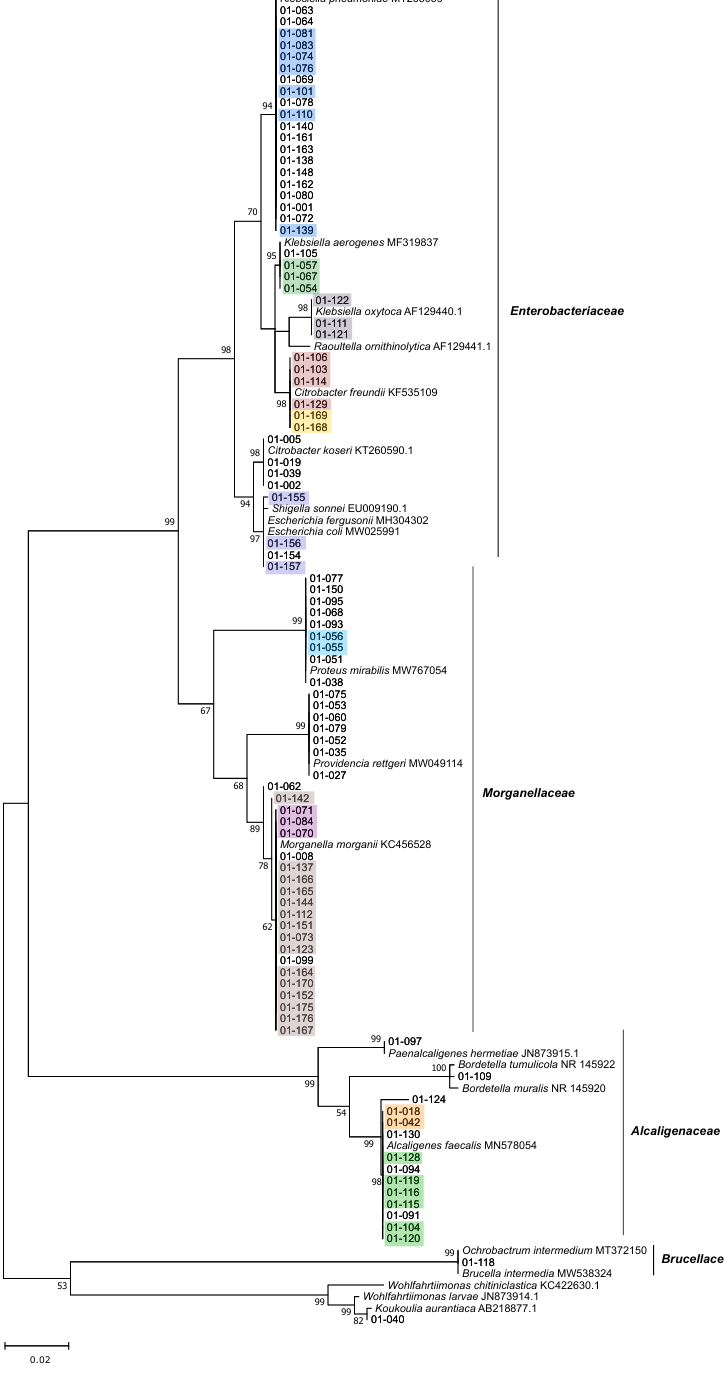
Figure 3. Unrooted maximum-likelihood tree of all BSFL gut isolates belonging to the phylum Proteobacteria represented, along with the closest related type strains and other relevant strains. Phylogenetic analysis was based on the unambiguous alignment (1306 sequence positions) of 16S rRNA gene sequences. GenBank accession numbers are included. Numbers at nodes indi- cate bootstrap values, based on 1000 replications. Identical isolates based on fingerprinting results (see Supplementary Figure S1) are marked with the same